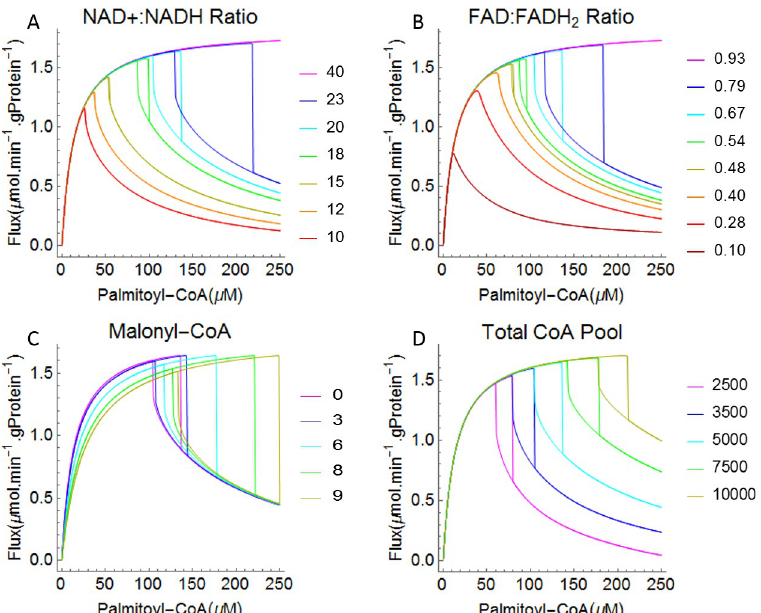
Fig 5. Bistability and hysteresis behaviour in mitochondrial fatty acid oxidation when varying selected model parameters. Simulated uptake fluxes for increasing and decreasing palmitoyl-CoA concentrations. A. [NAD +] : [NADH] ratio varying between 10 and 40, without altering the sum of [NAD + ] and [NADH]. B. [FAD]:[FADH2] ratio varying between 0.10 and 0.93. C. Malonyl-CoA varying between 0 and 10 μ M. D. Total CoA varying between 2500 and 10000 μ